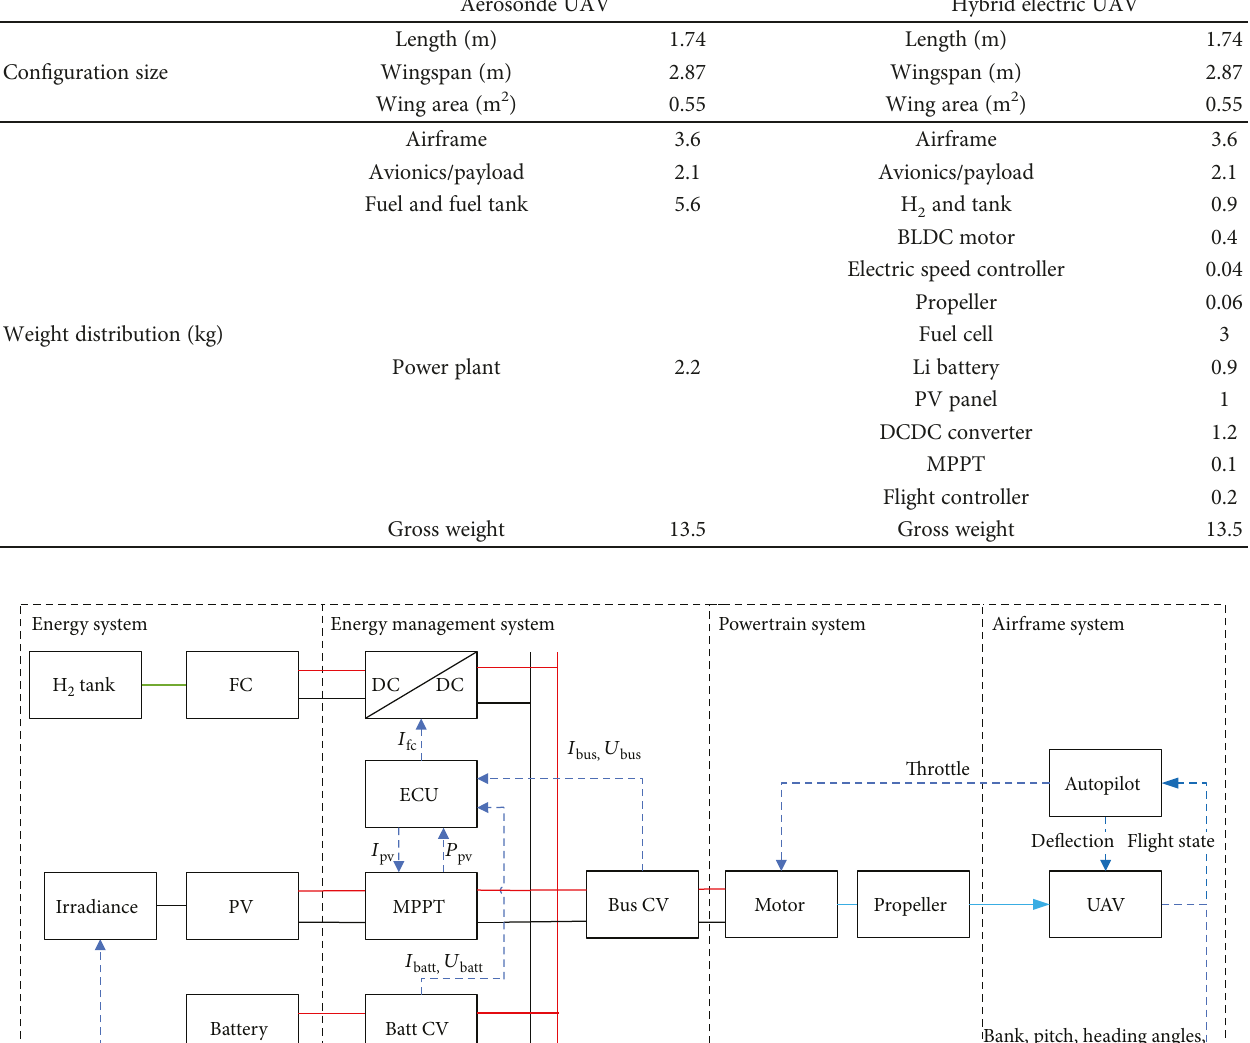
Table 1: Comparison of the Aerosonde UAV and hybrid electric UAV.